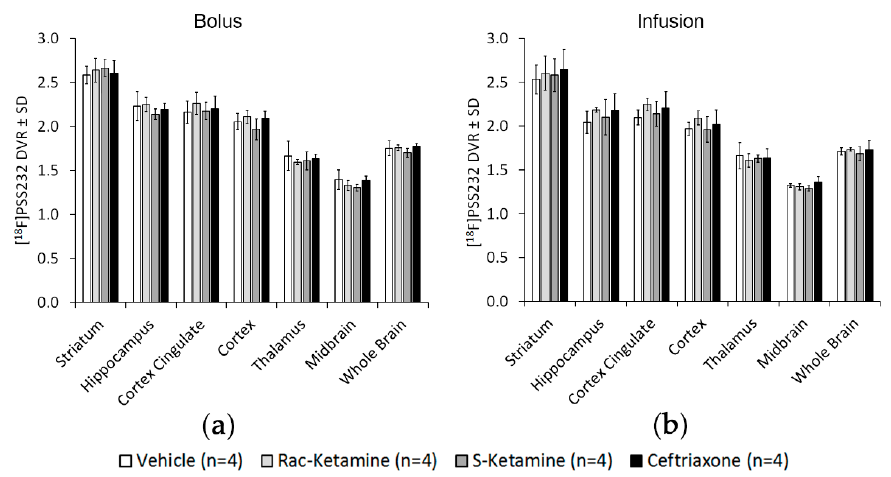
Figure 2. Influence of ( a ) bolus injection or ( b ) infusion of vehicle (0.9% NaCl), racemic ketamine, S-ketamine and ceftriaxone on [ 18 F]PSS232 distribution volume ratios (DVRs) in different rat brain regions. Number of animals as depicted. SD, standard deviations.